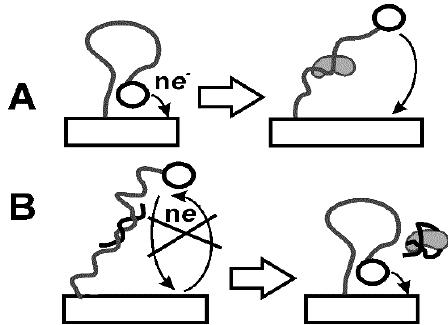
Figure 10. E-sensor based on double-labeled loop aptamer ( A ) and application of partially complementary auxiliary DNA sequence ( B ).